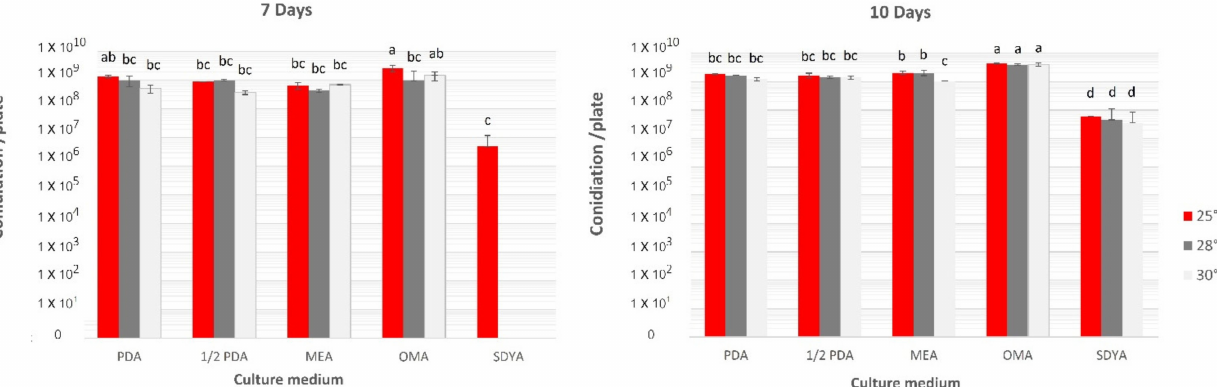
Figure 5. The functional category in the genome of Metarhizium sp. BCC 4849 predicted based on the gene ontology as follows: ( A ) molecular function, ( B ) biological process, and ( C ) cellular location.